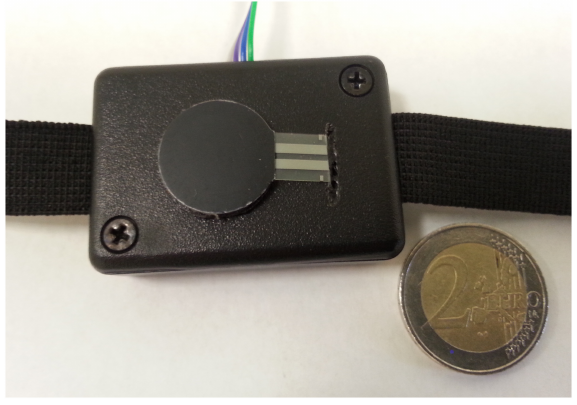
Fig. 6. Diaphragm tension